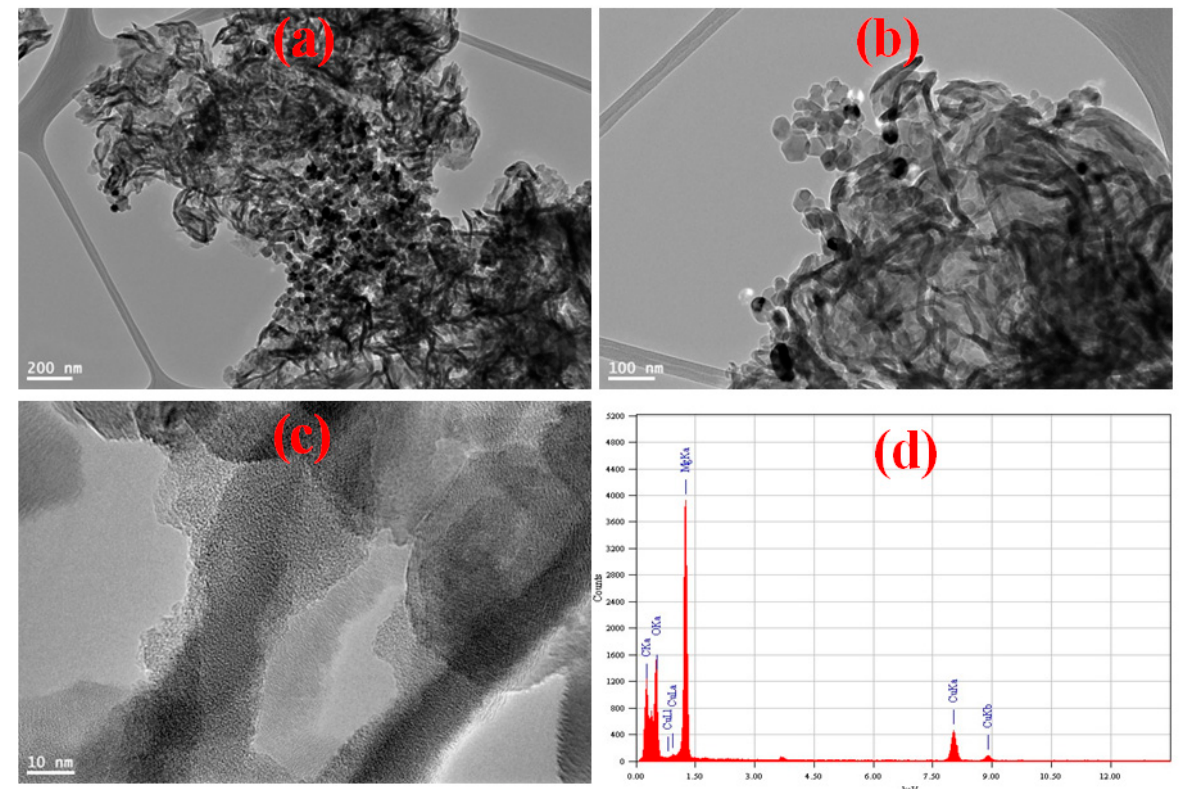
Figure 3. ( a – c ) TEM micrographs, ( d ) EDX spectrum with the corresponding chemical composition of MGCN sorbent.